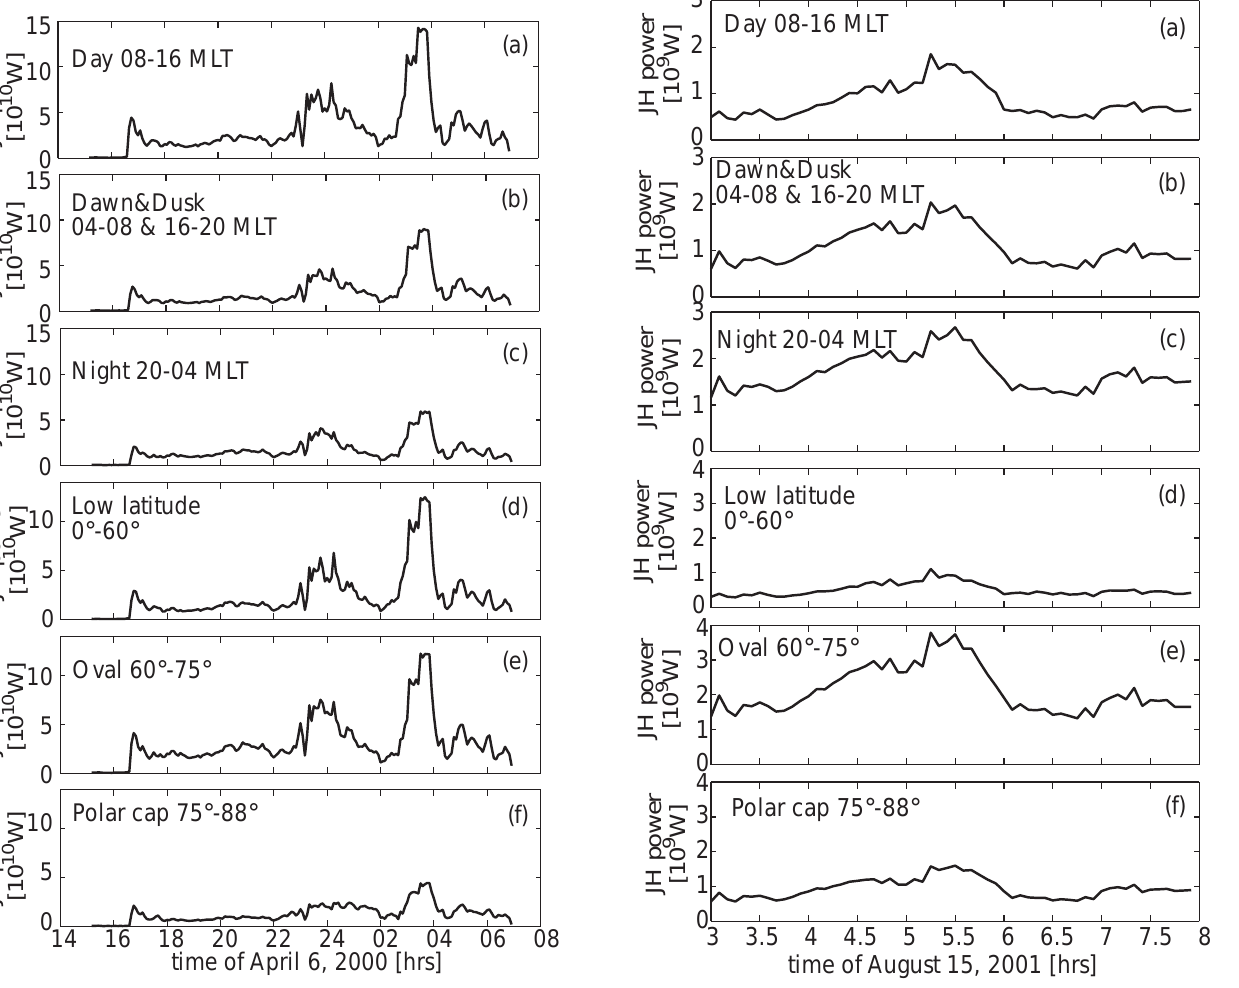
Fig. 10. Joule heating power during the 15 August 2001 substorm in the (a) dayside 08:00–16:00 MLT, (b) dawn 04:00–08:00 MLT and dusk 16:00–20:00 MLT, (c) nightside 20:00–04:00 MLT, (d) low latitudes 0 ◦ –60 ◦ , (e) oval latitudes 60 ◦ –75 ◦ , and (f) polar cap latitudes 75 ◦ –88 ◦ . Both hemispheres are present in